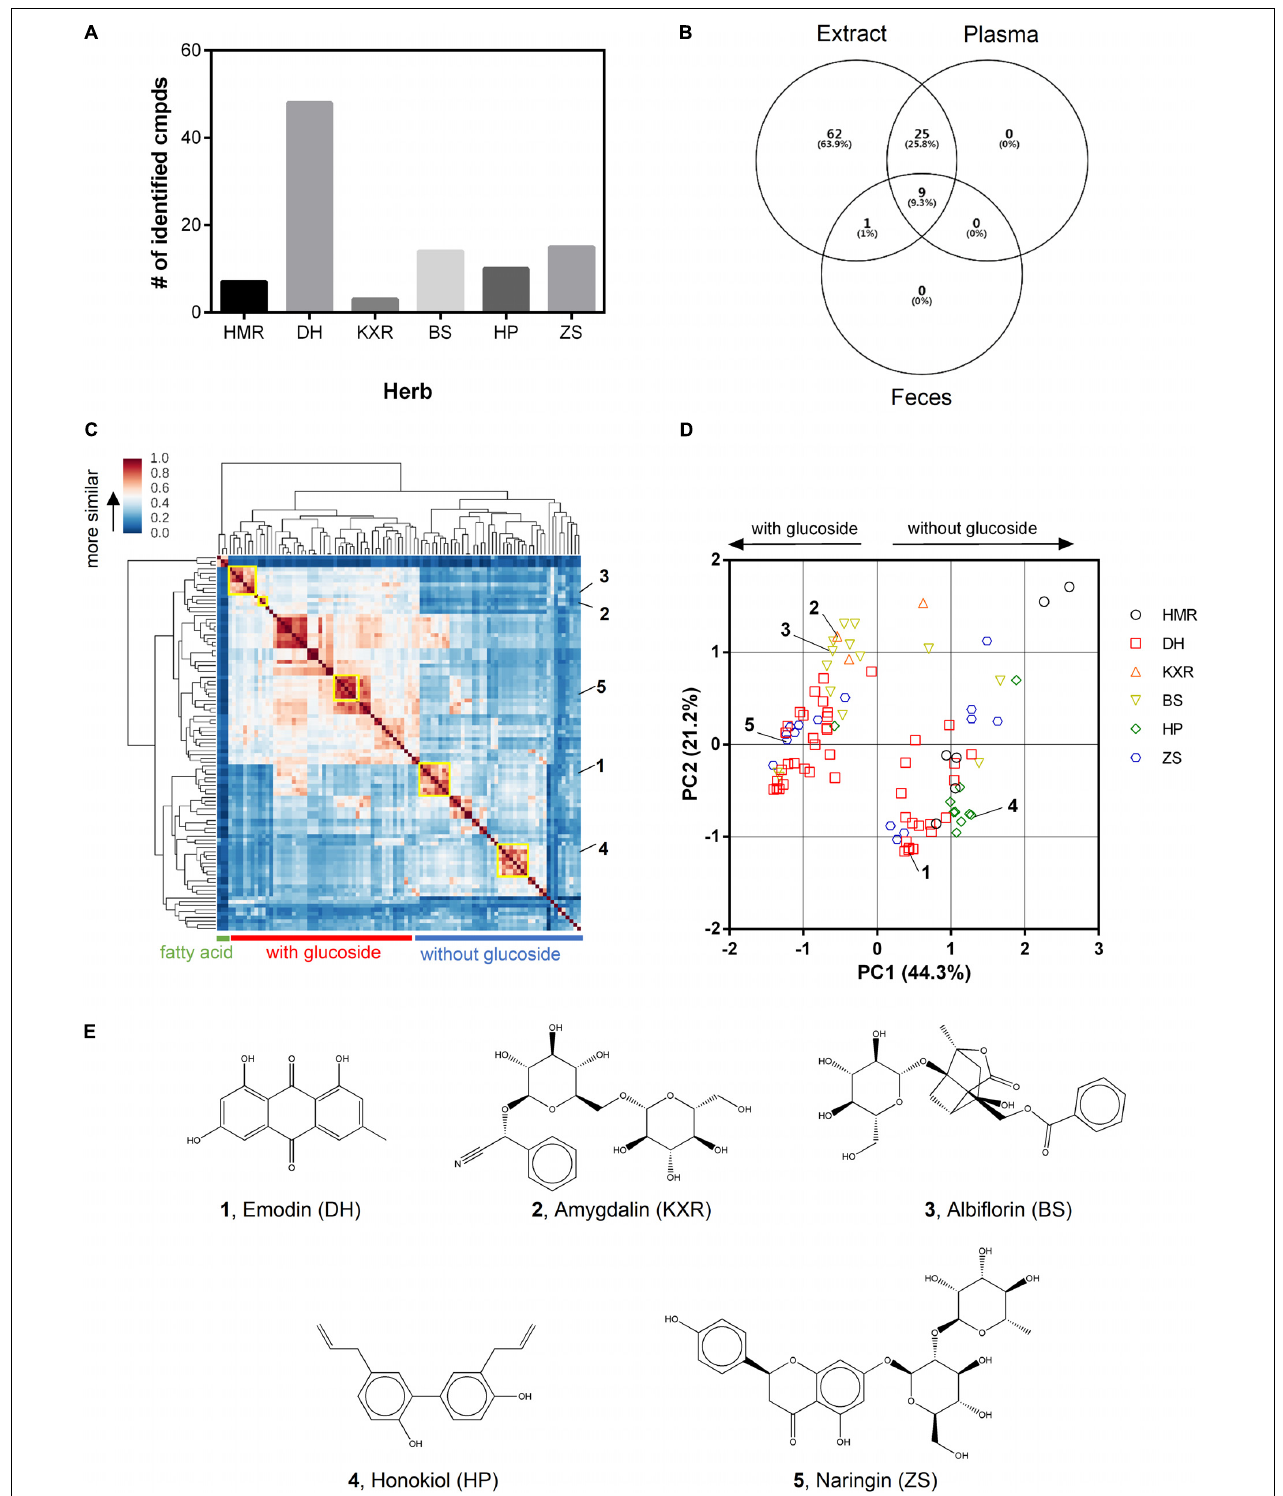
FIGURE 1 | Identification of compounds of MZRW in extract and biological samples and selection of representative compounds. (A) Histogram of number of identified compounds by herbs. (B) Venn diagram of number of identified compounds by extract and biological samples. (C) Clustering analysis of identified compounds based on chemical similarity. Component groups were highlighted by yellow rectangle. (D) PCA analysis of identified compounds according to chemical similarity. (E) Representative compounds of each component group.